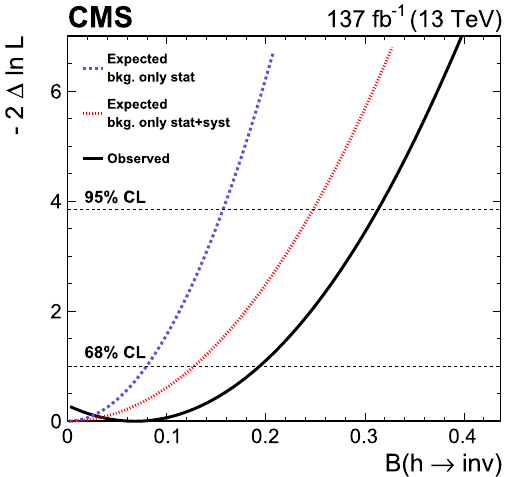
Fig. 9 The value of the negative log-likelihood, − 2 Δ ln L , as a func- tion of the branching fraction of the Higgs boson decaying to invisible particles